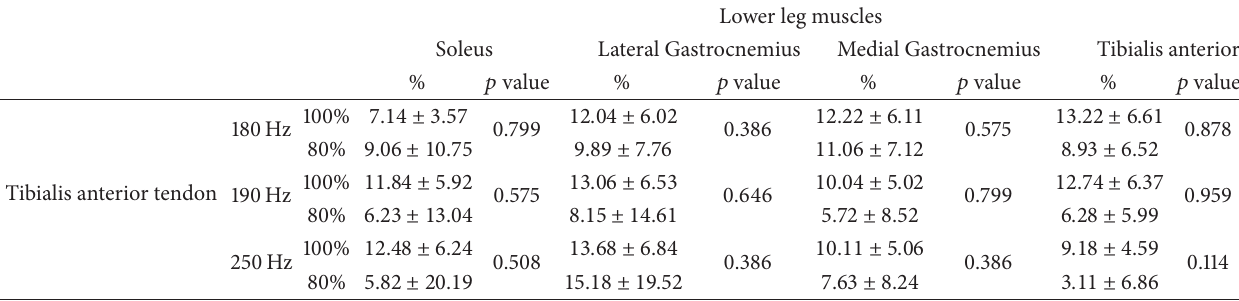
Table 3: The increase rate of muscle force according to the intensity of vibration, perception threshold (100%) and subthreshold (80%) on the tibialis anterior tendon [%].